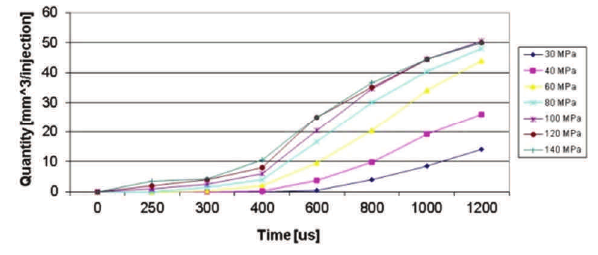
Fig. 12. Characteristic with pump speed 800 rpm